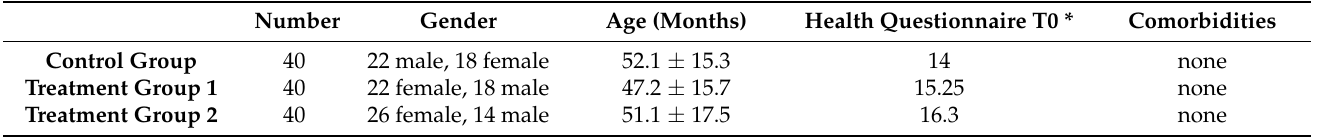
Table 2. Demographic characteristics at the